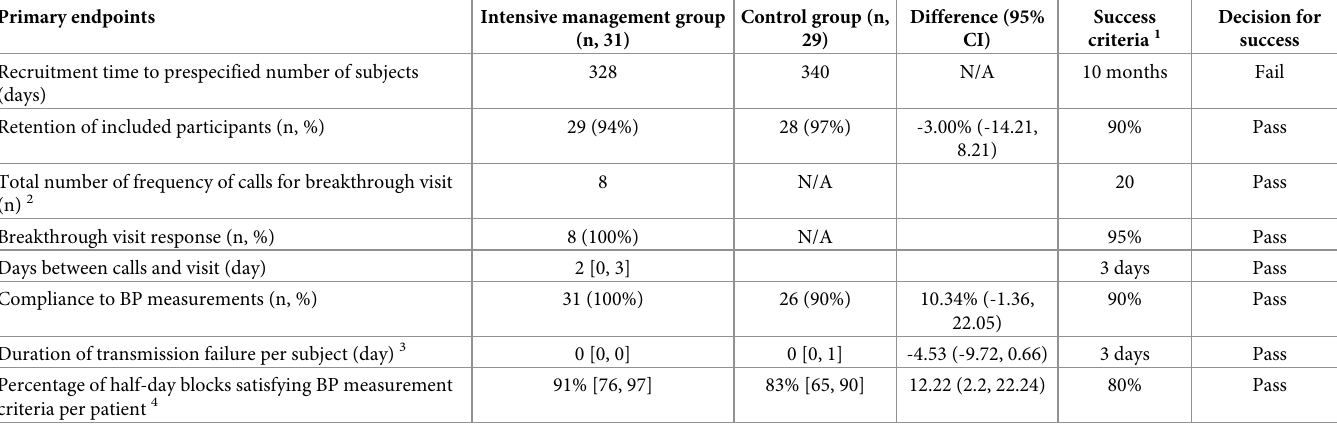
follow-up weeks after randomization. In this analysis, a center effect was adjusted as a random factor. Due to a non-significant interaction between the study group and elapsed weeks from randomization, a test for equality as well as linear trend of mean SBP or DBP variables across weeks were performed for all participants (S2 Table). All the statistical analyses were performed using the SAS 9.4 (SAS Institute, Cary, NC, USA) with a two-sided test, and statistical significance set at alpha = 0.05. Table 2. Results of primary endpoints and criteria for success of feasibility.